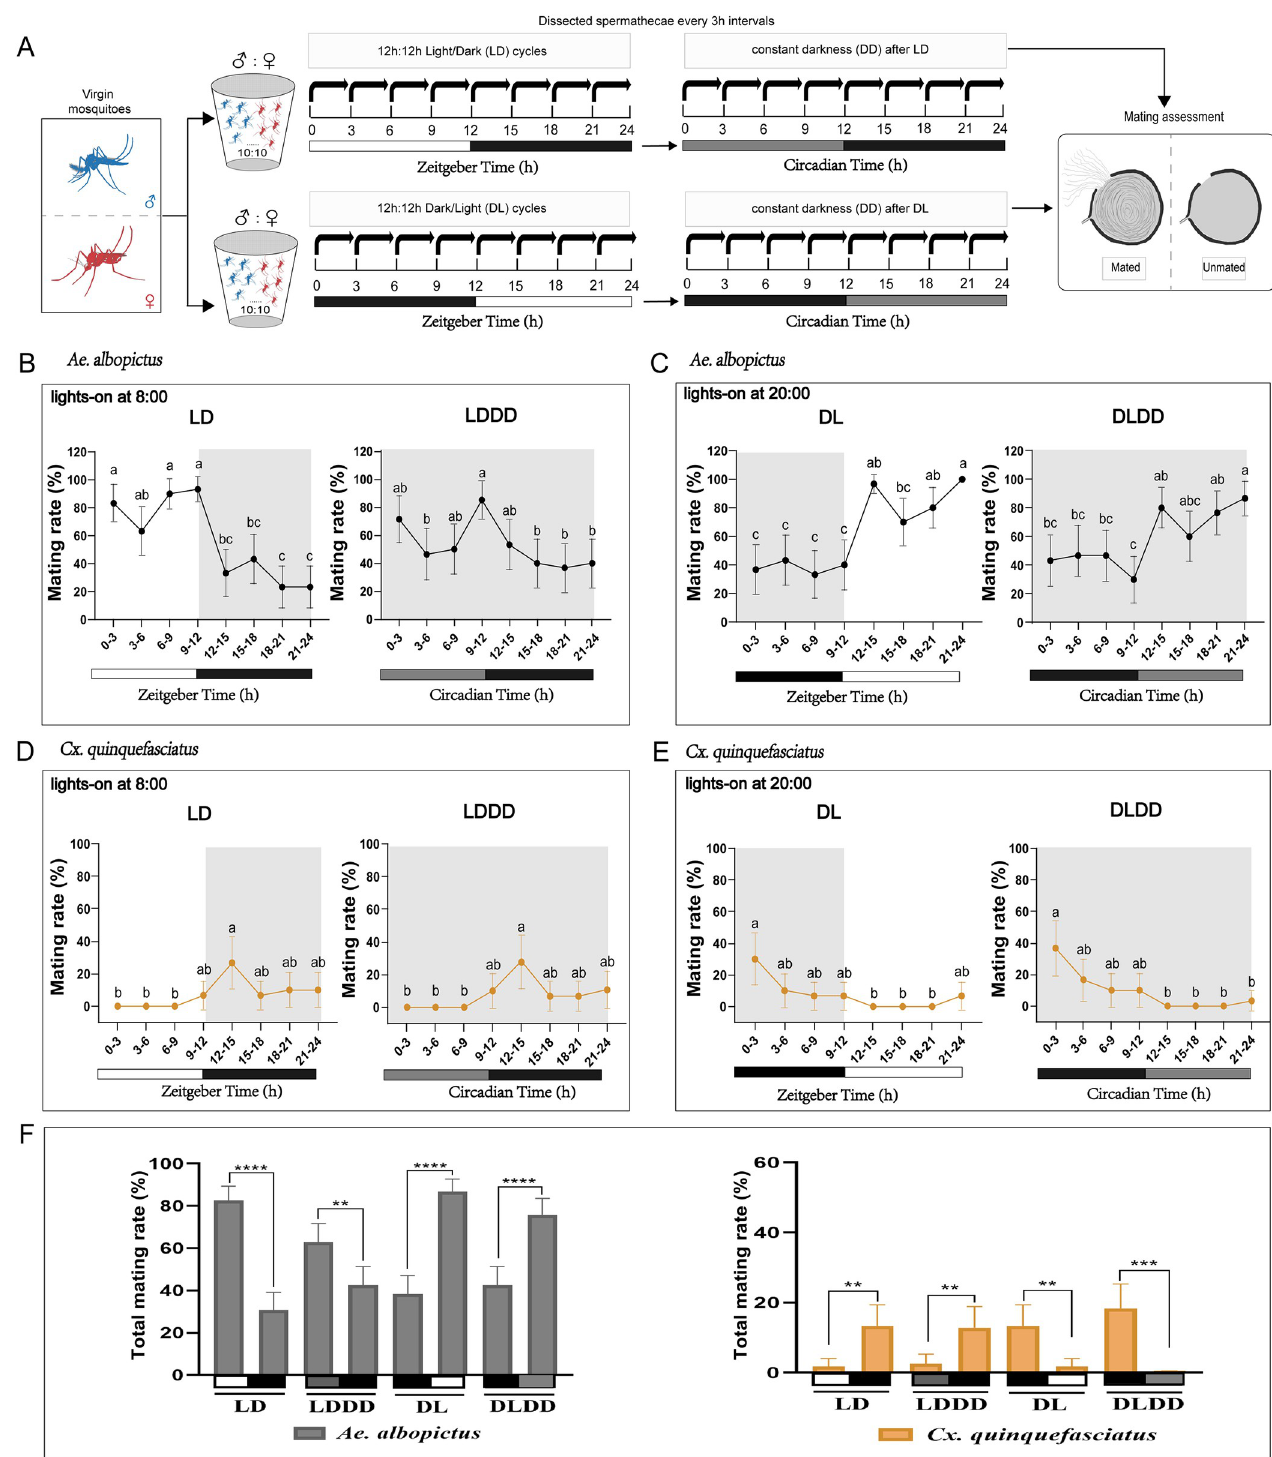
Fig 1. Mating activities of Ae . albopictus and Cx . quinquefasciatus at different times of the day under different light conditions. ( A ) Experimental flow chart of mating rate of Ae . albopictus and Cx . quinquefasciatus at different zeitgeber times in a day. Blue represents male mosquitoes and red represents female mosquitoes. ( B ) Daily changes in mating activities of Ae . albopictus on day 4 under 12:12 light/dark (LD) cycles (lights on at ZT0) and mating activities on day 2 under constant dark (DD) after 4 days of entrainment in LD cycles. (C) Daily changes in mating activities of Ae . albopictus on day 4 under 12:12 dark/light (DL) cycles (lights on at ZT12) and mating activities on day 2 under DD after 4 days of entrainment in DL cycles. (D) Daily changes in mating activities of Cx .